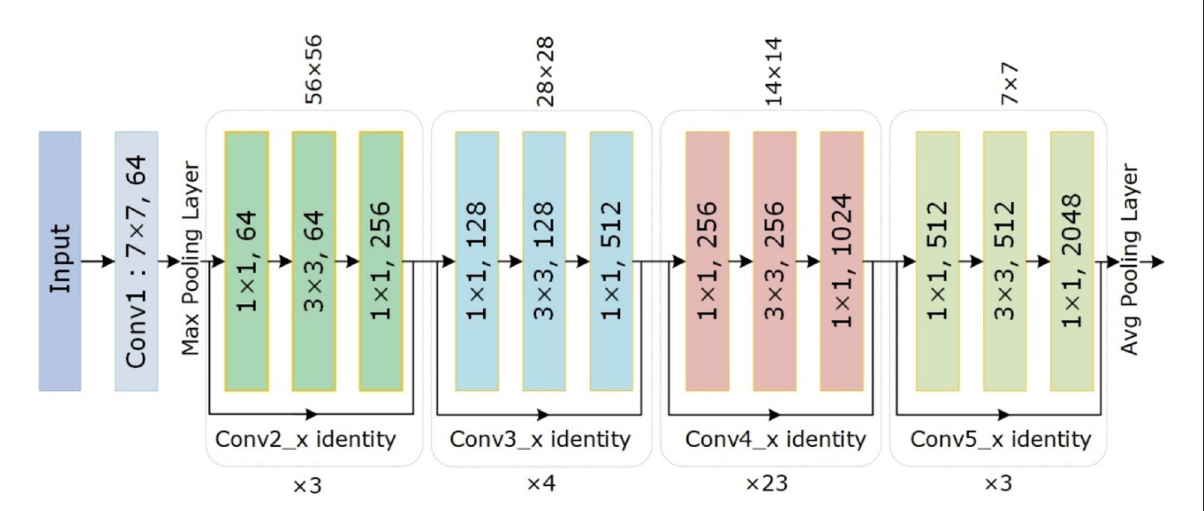
FIGURE2 The architectural view of ResNet-101.